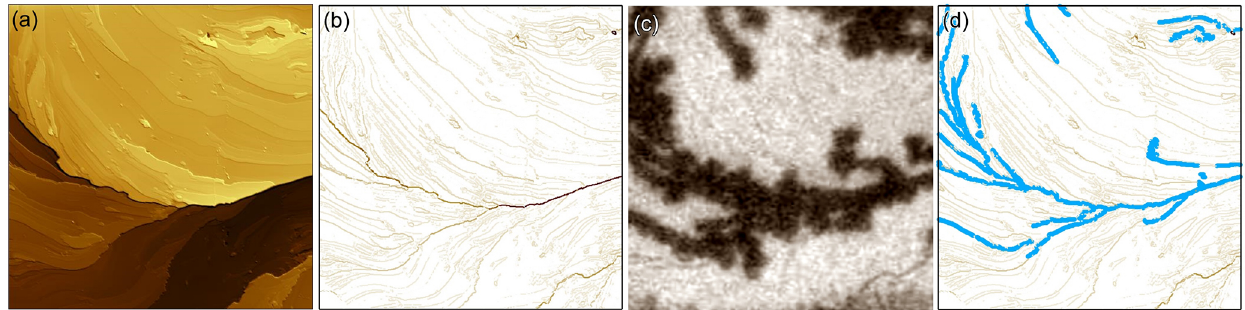
Figure 5. Processing video and AFM data into step-height statistics. An AFM image (a) is converted to an image of step heights (b) and compared to the corresponding optical image of ice formation (c) . The step-height image in (b) is interactive in that the traces corresponding to ice-covered step segments can be selected by mouse click, shown as blue traces in (d) .